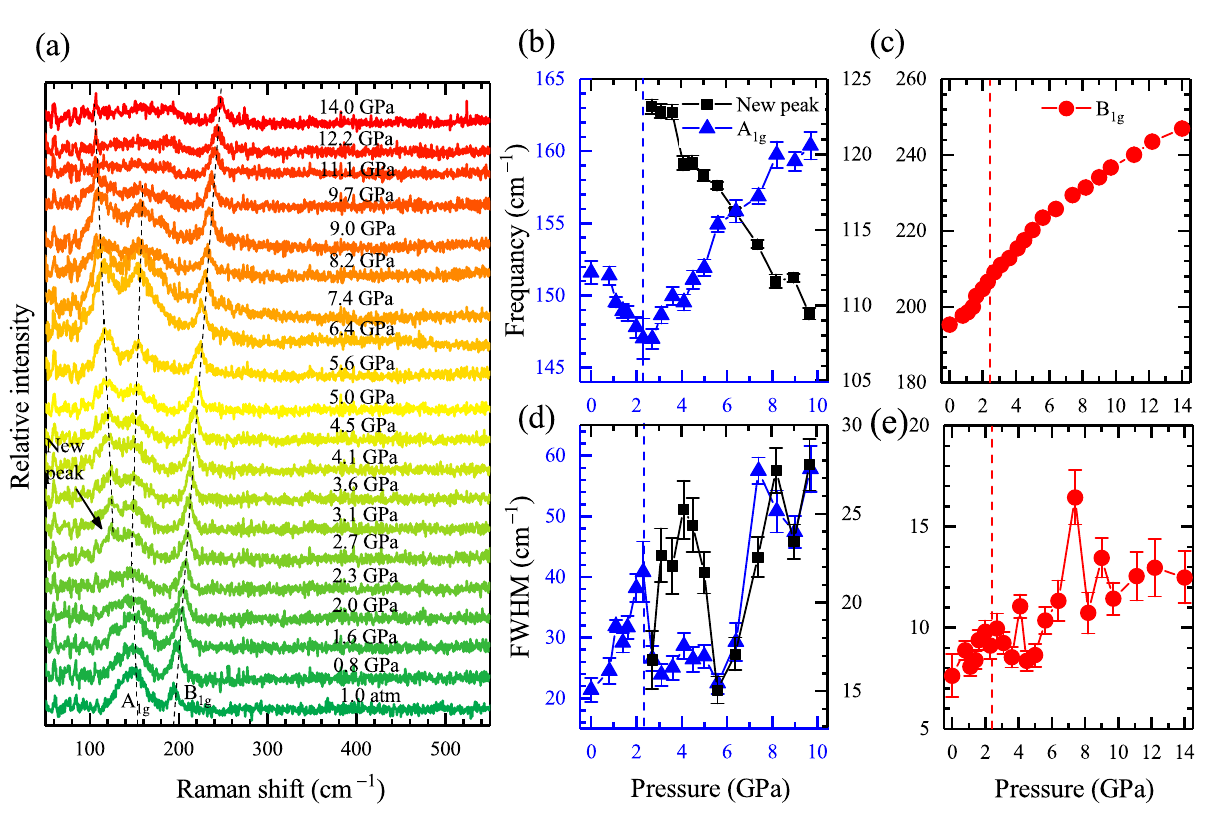
Figure 4. Pressure-dependent Raman scattering spectroscopy FeTe 0.5 Se 0.5 . ( a ) Experimental data in the pressure range from 0 to 14 GPa. The solid lines with gradient ramps are the curves of the raw data at different pressures. Two Raman active modes, the A 1 g and B 1 g phonon modes, are observed. Above 2.3 GPa, a new peak with a wavelength of approximately 123 cm − 1 appears, marked by a black arrow. The tracks of the positions of the three peaks are marked by black dash lines. ( b – e ) Pressure dependence of the frequency ( b , c ) and FWHM ( d , e ). The red and blue symbols denote the fitting results of the A 1 g and B 1 g modes, respectively. The black symbols denote the fitting results of the new